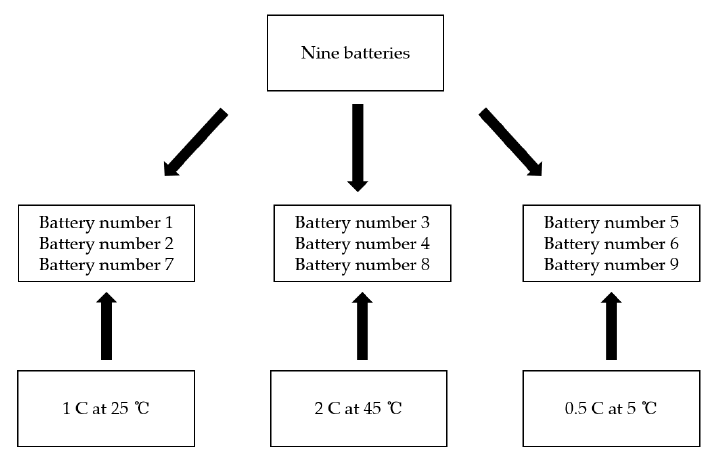
Figure 7. Battery grouping process.